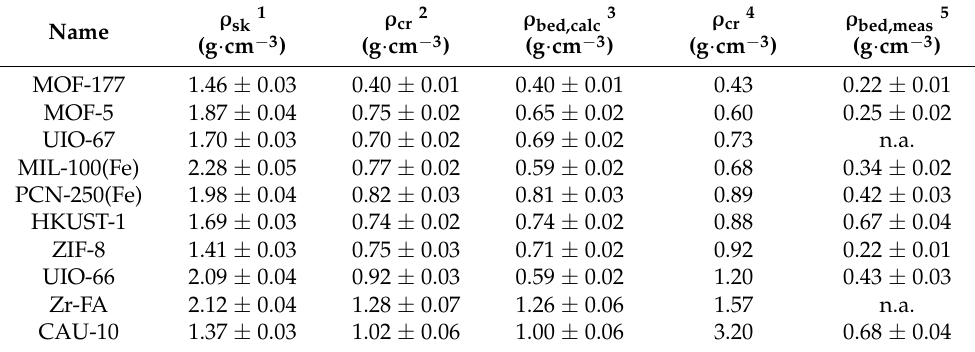
Table 2. Measured density values for